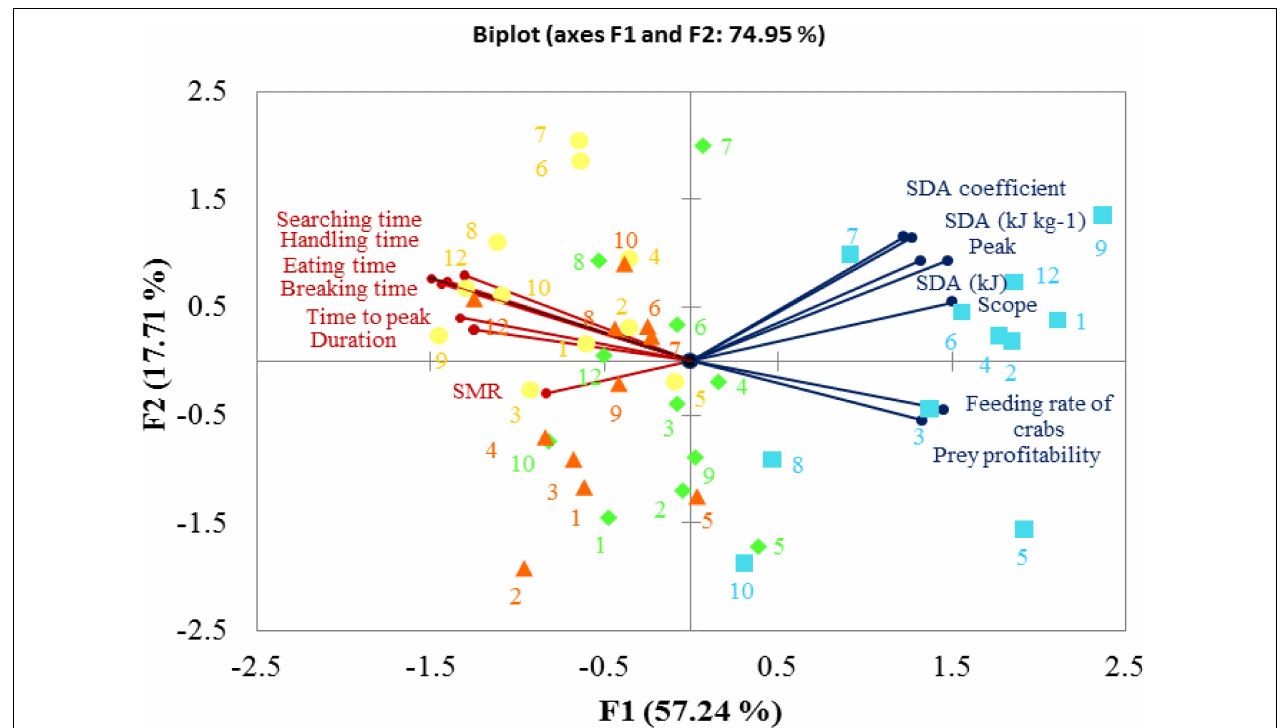
FIGURE 8 | Biplot originating from a principal component analysis integrating all variables measured in C. pagurus following four progressive treatments ( (cid:3) –initial pH